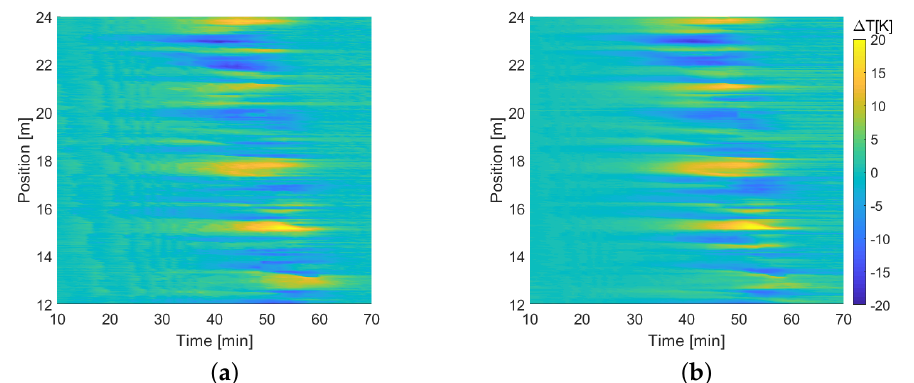
Figure 11. Temperature fluctuations as a function of time and position, along a subsection of the SC link, as measured by ( a ) the Acrylate250 sample, and ( b ) the PEEK400